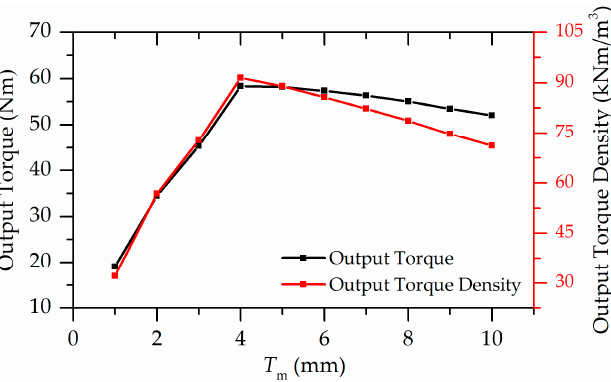
Figure 6. Output torque and output torque density curves versus T m .